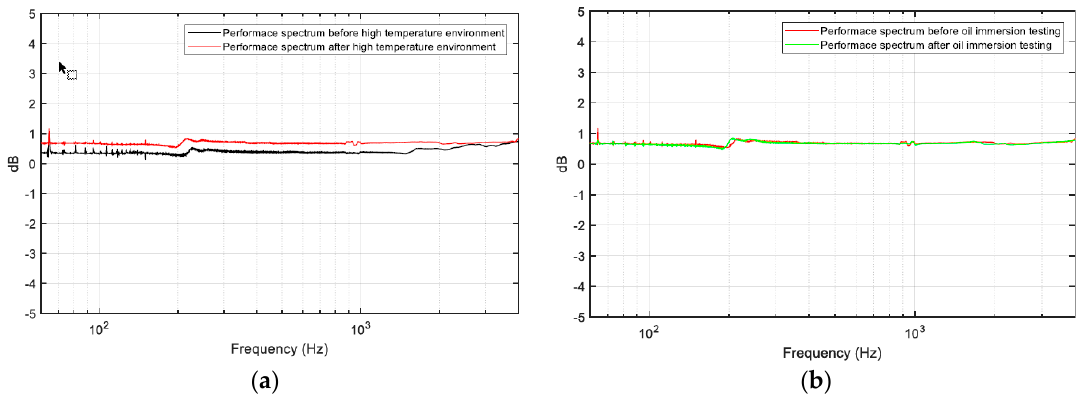
Figure 3. Comparison between measured performance spectrum for accelerometer before and after. ( a ) high temperature testing. ( b ) oil immersion testing in simulated aero engine